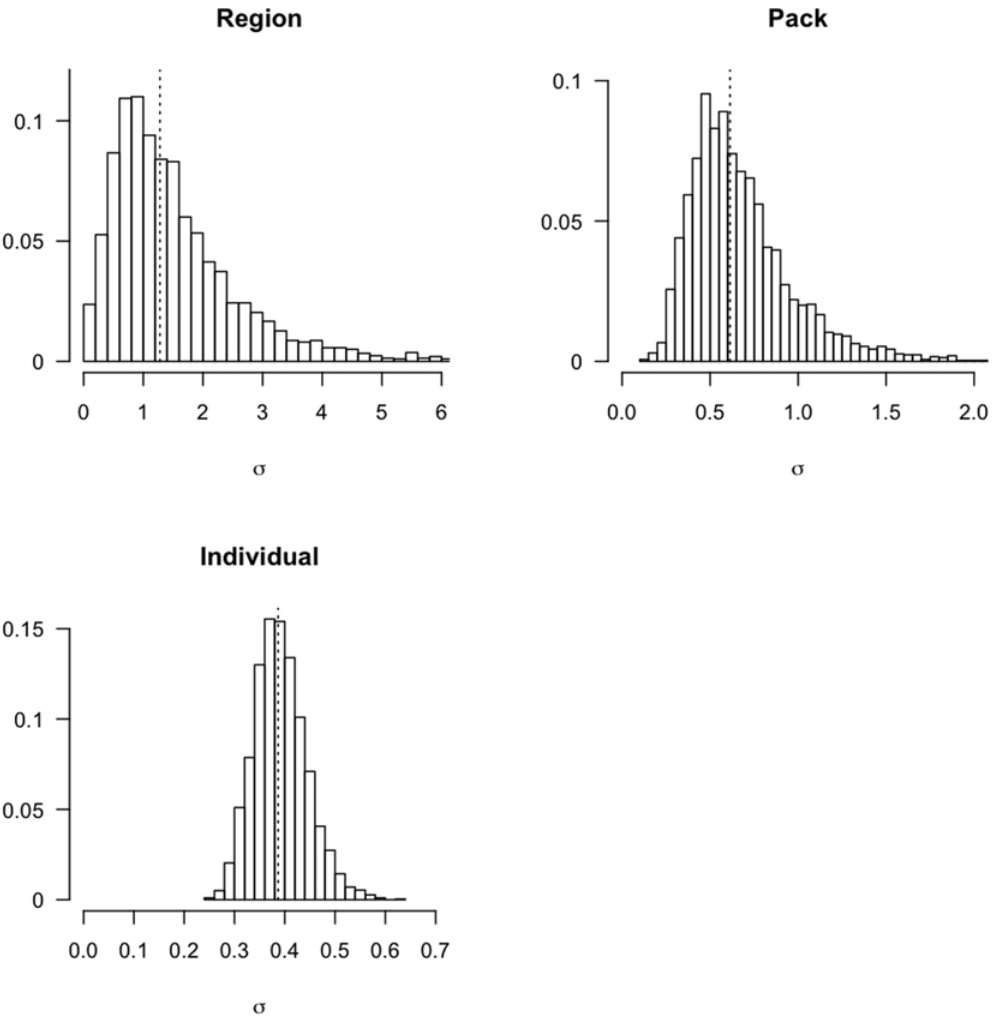
Figure 3. Estimated posterior density for the standard deviation parameters controlling the variation in diet across three scales (sub-population, social group, individual). Posterior densities are estimated from the model with the lowest DIC value, with medians indicated by dashed lines.